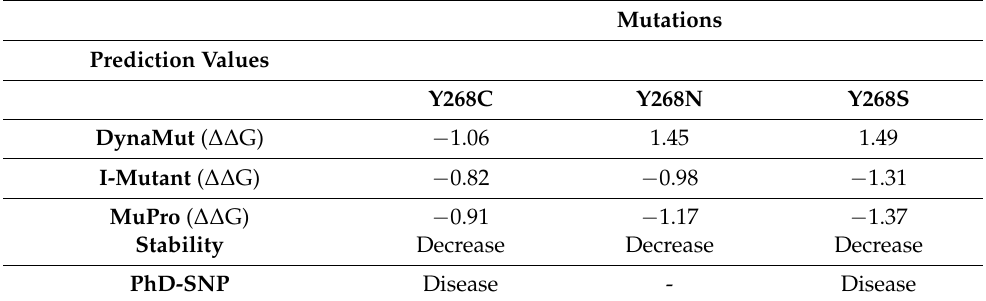
Table 1. Prediction on the effect of mutations (Y268C, Y268N and Y268S) on PfCytb-ISP protein stability using VAPOR and DynaMut. The tools define ∆∆ G > 0 as stabilizing and ∆∆ G < 0 as